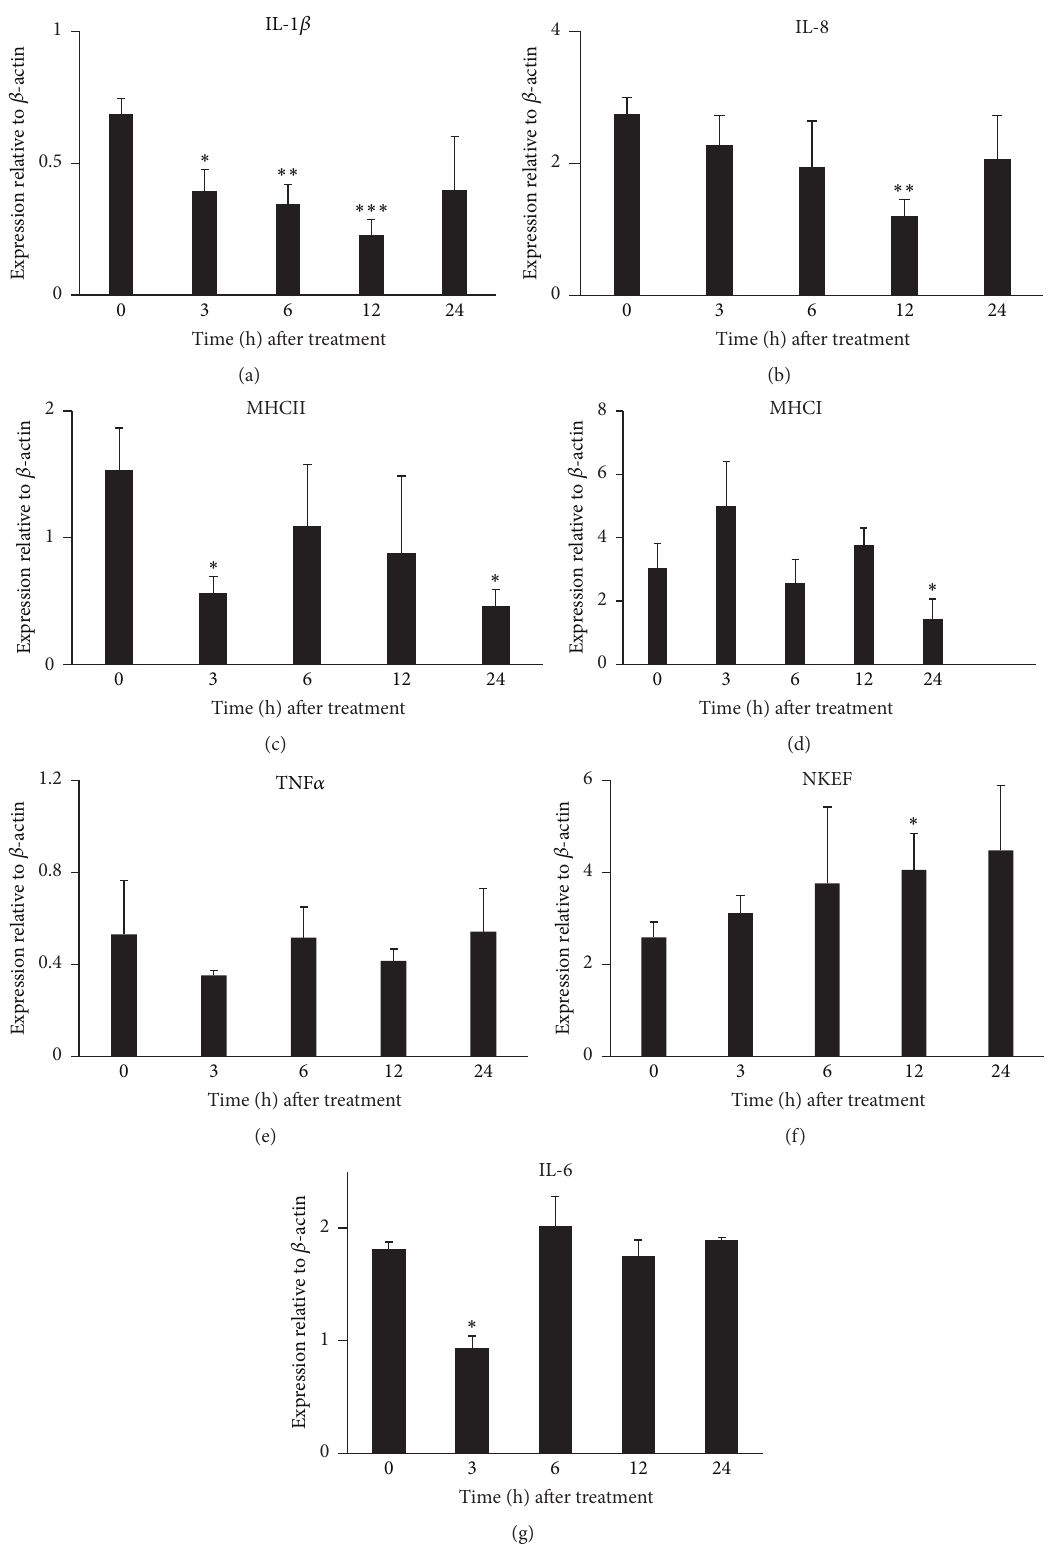
Figure 5: Analysis of expression of different immune genes in spleen of L. rohita administered with r Lr IL-10 at different time points after treatment. The bars represent expression of the respective gene relative to 𝛽 -actin gene at respective time point. Bars represent mean values ( ± SD) of three samples. Statistically significant expression of gene relative to control is denoted by “ ∗ ” at 𝑝 ≤ 0.05 ; “ ∗∗ ” at 𝑝 ≤ 0.005 ; “ ∗ ∗ ∗ ” at 𝑝 ≤ 0.001